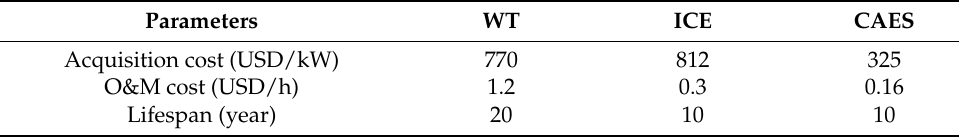
Table 2. Parameters of the capital cost.